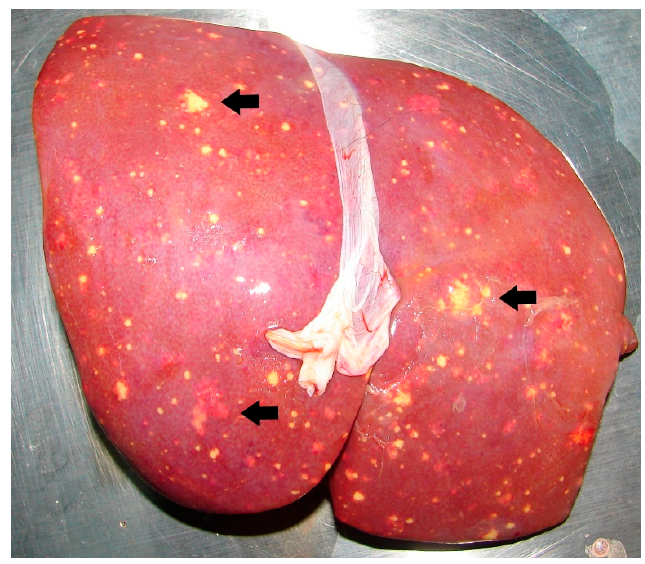
Figure 2. Multifocal abscess (black arrows) in the liver of a Douc langur with melioidosis.